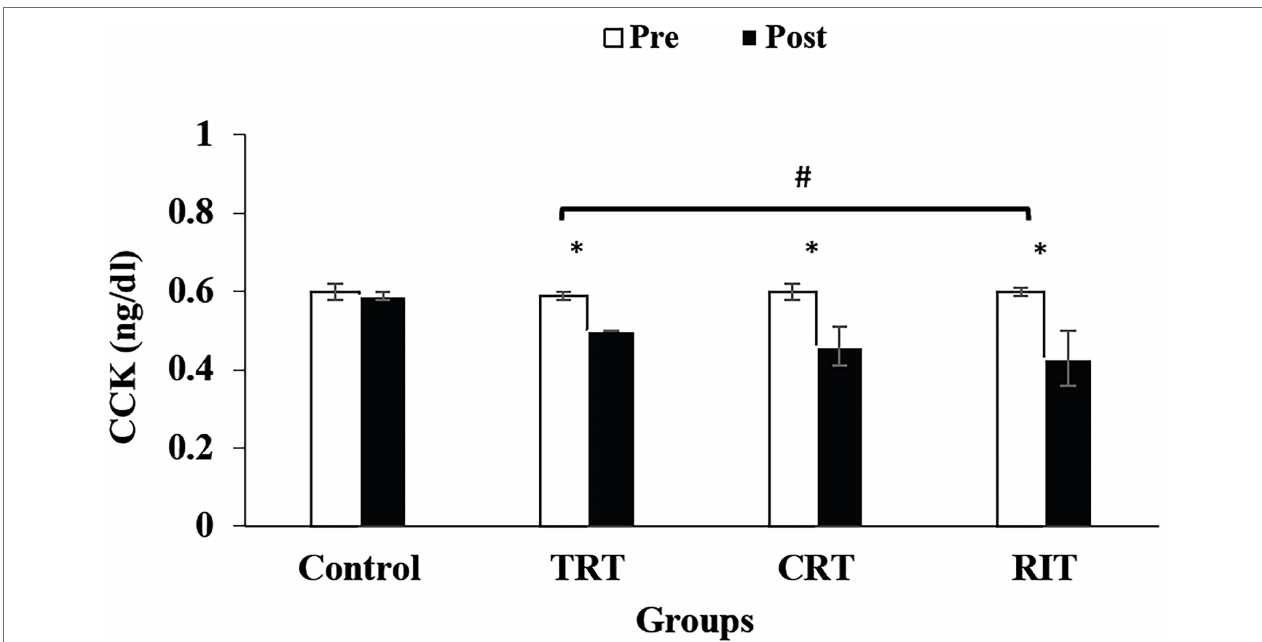
FIGURE 3 | Pre- and post-training values (mean ± SD) for Cholecystokinin in TRT, CRT, and IRT groups. * Indicates significant differences from the control protocols ( p < 0.05). # Indicated significant differences between training groups ( p < 0.05).